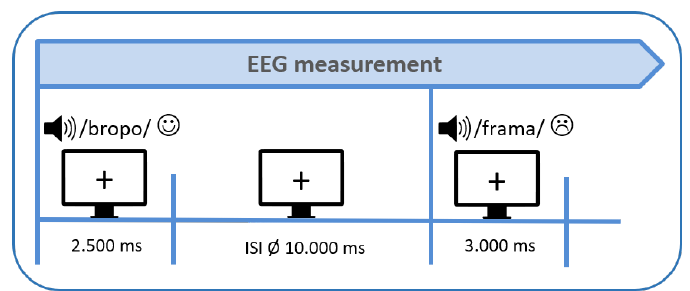
Figure 4. Experimental design (ISI = inter-stimulus-interval, EEG = electroencephalography). After the pretest, one guided session of Tapping (experimental group) or Progressive Muscle Relaxation (PMR; control group) was conducted, lasting about 60 min each. After the intervention there was a standardized break of 15 min. Subsequently, participants of both groups completed PANAS, KSS, and NAS again to track potential changes over time. Then they performed the posttest, while undergoing the same experimental session as in the pretest. The whole procedure (shown in Figure 3) started between 10 – 11 am, which guaranteed comparable conditions for all subjects.